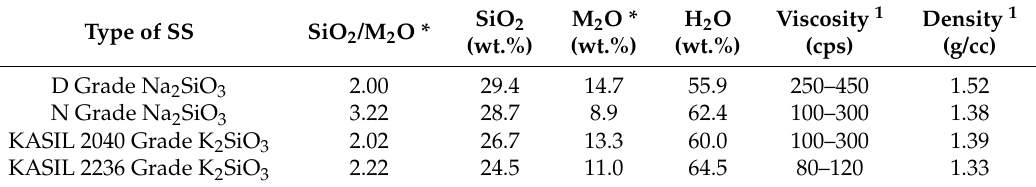
Table 2. Specifications of the silicate solutions